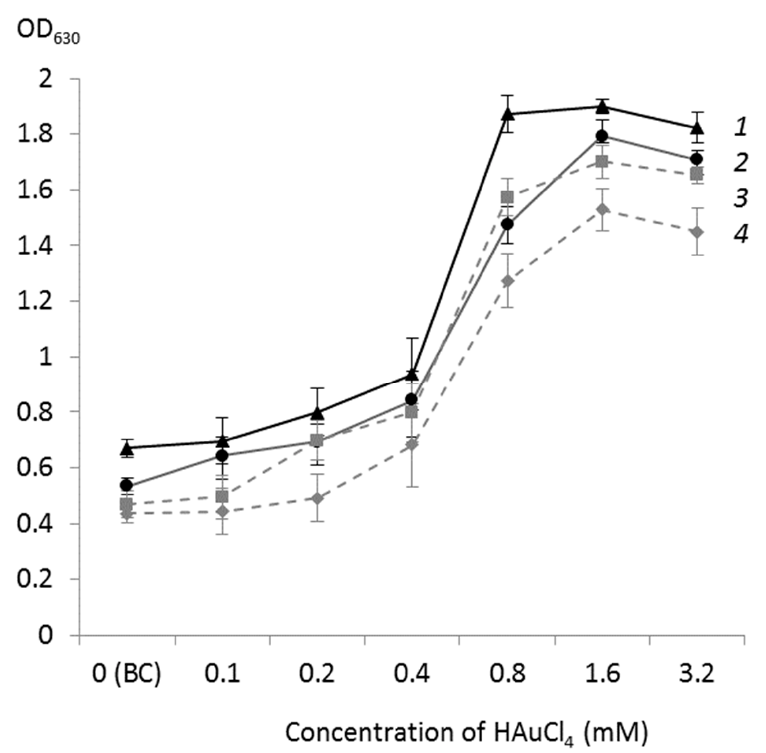
Figure 1. Effects of different HAuCl 4 concentrations on the viability of Rhodococcus spp. (OD 630 values of cell suspensions after staining with INT). BC—biotic control, (1)— R. erythropolis IEGM 766, (2)— R. ruber IEGM 1135, (3)— R. rhodochrous IEGM 1162, and (4)— R. fascians IEGM 525.